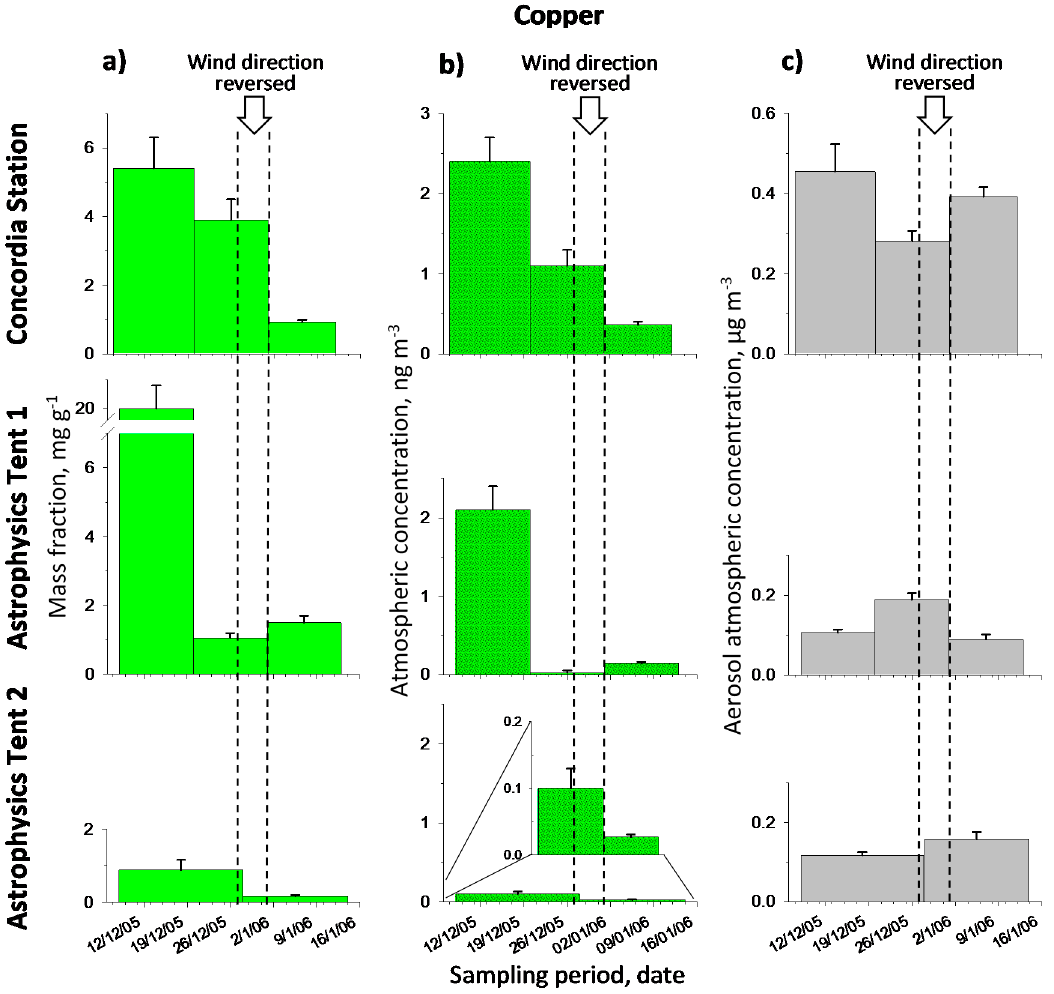
Figure 4. Temporal trends of Cu content at Dome C during the 2005–2006 austral summer, for ( a ) mass fraction and ( b ) atmospheric concentration. In ( c ), aerosol atmospheric concentration reported for comparison (redrawn from [42]).